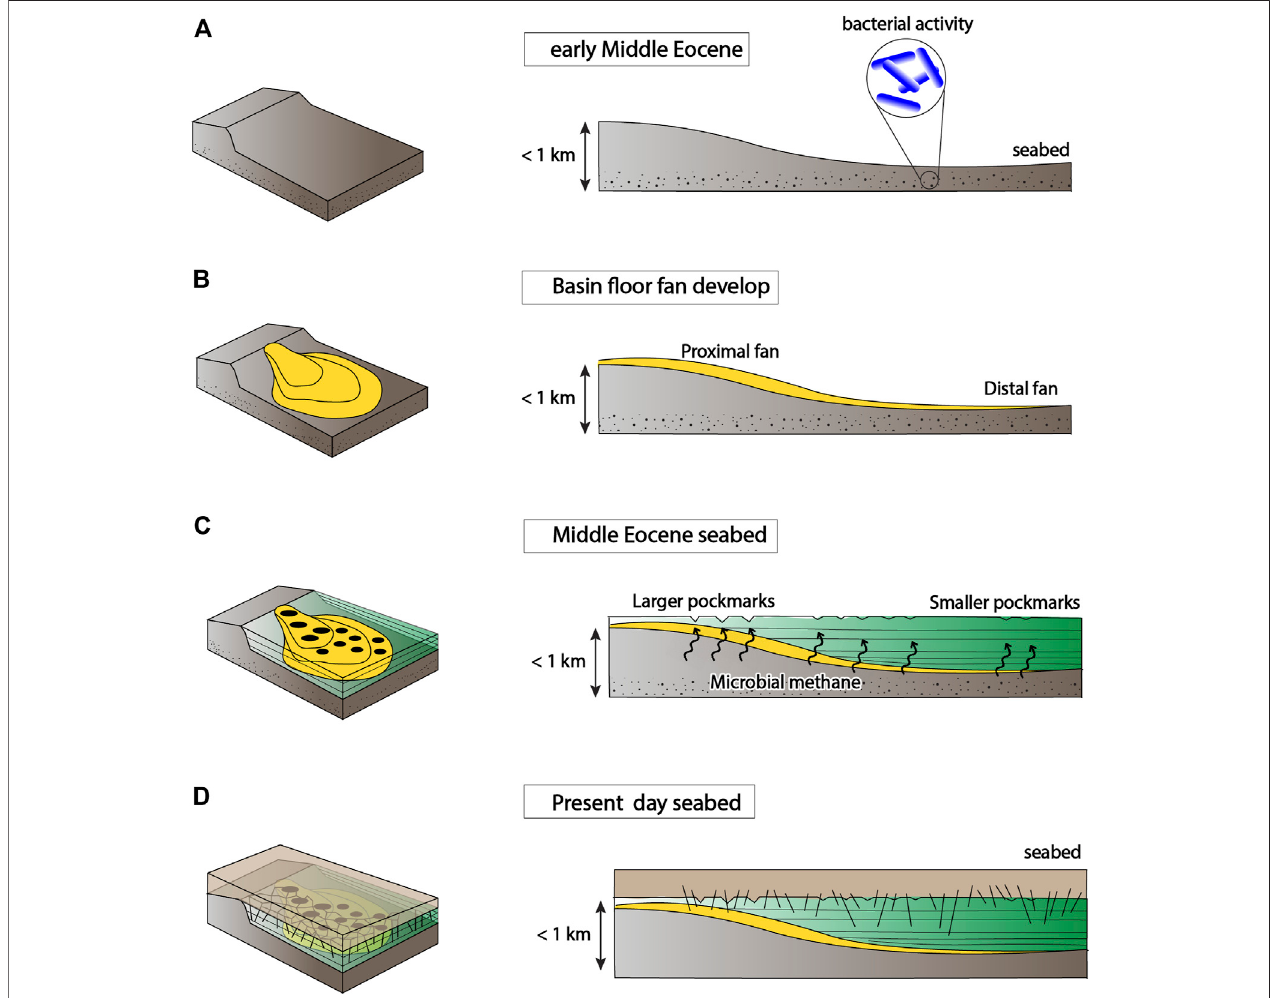
FIGURE 14 | Schematic evolutionary cartoon of the paleo-pockmark formation in the Great South Basin based on the occurrence of microbial methane from the early Middle Eocene to present day. (A) Initial deposition of sedimentary formation and microbial methane generation during the early Middle Eocene. (B) Basin fl oor fan development on top of the initial deposition. (C) Transgressive marine mudstones continue to deposit providing a seal on top of the fan and creating a new seabed. Substantialincrease inpore pressureduetomicrobialmigrationeventuallyleadstoexpulsionofmicrobialmethaneontheseabed. (D) Sea-levelriseledtoyounger mud and carbonate sediments being deposited onto the Laing Formation and burying the paleo-pockmarks.